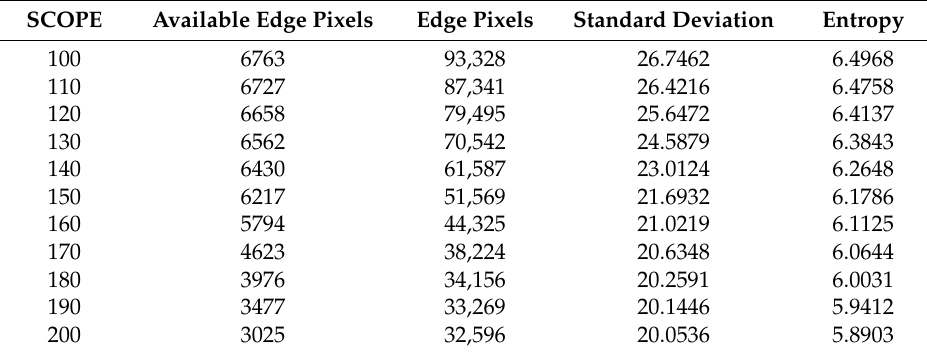
Table 6. The values of standard deviation, entropy, available edge pixels and edge pixels corresponding to the values of different parameter SCOPE.